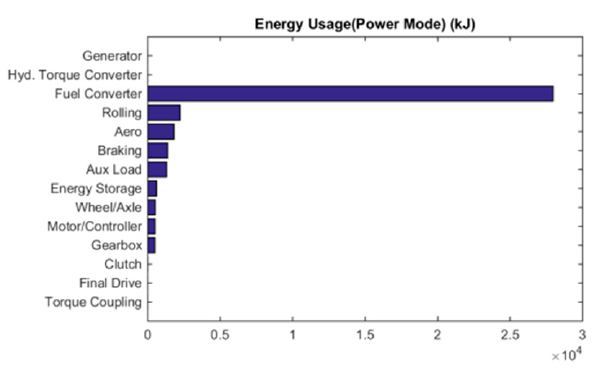
Figure 7. Energy use power mode.